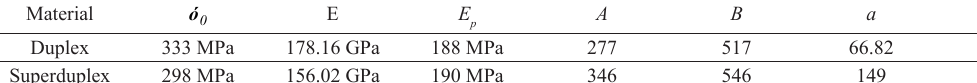
Table 3. Summary of elasto-viscoplasticity parameters of duplex and superduplex stainless